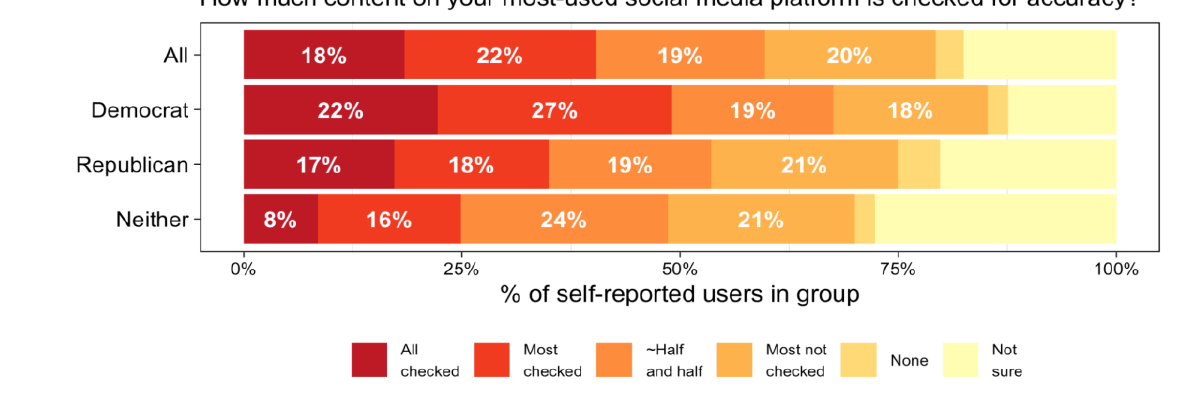
Figure 2. Perception of misinformation intervention frequency. Percentage of responses ( x -axis) in each frequency category (colored bar) are shown for each subgroup ( y -axis). For brevity, response p ercentages are only omitted for the “None” and “Not sure” categories. This survey question was asked after identifying each respondent’s most -used social media platform in the previous month.